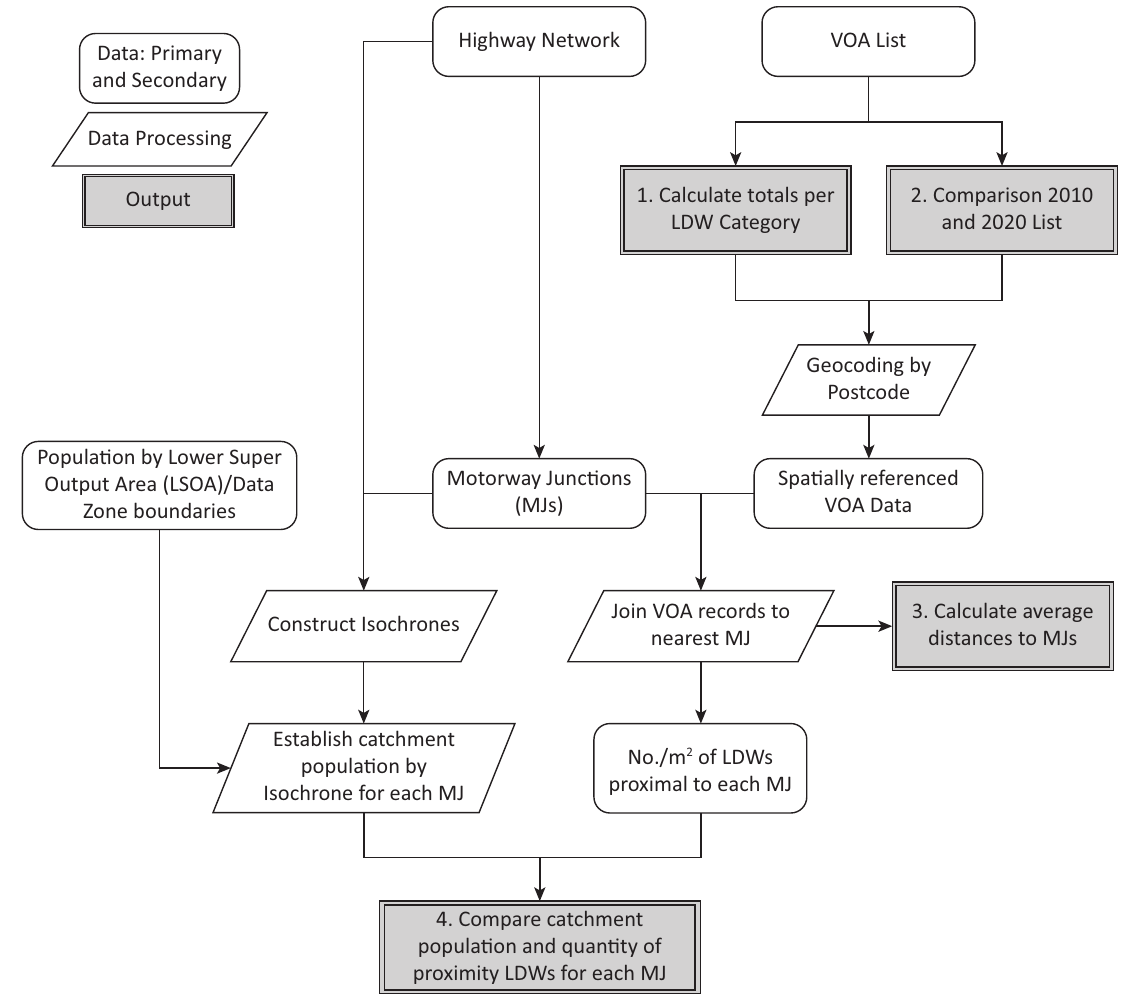
Figure 1. Research method and analysis